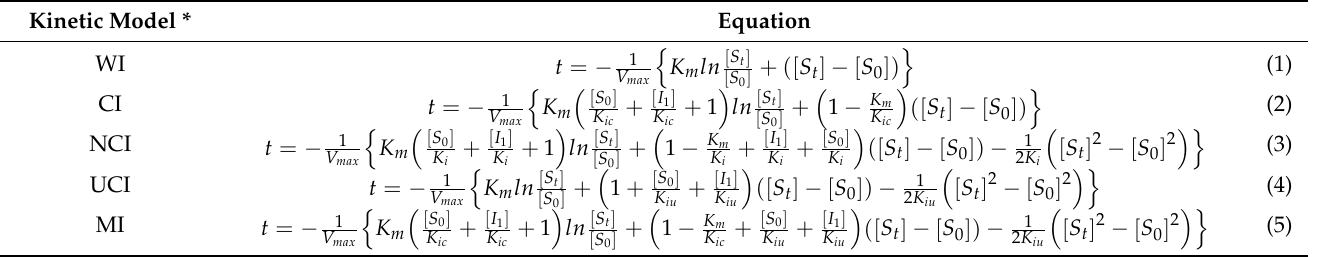
Table 1. Integrated Michaelis–Menten equations obtained from the model explained in Figure 1, assuming product inhibition